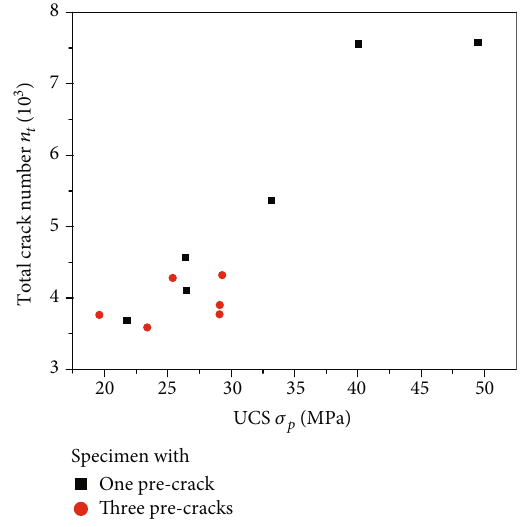
Figure 15: Correspondence between the UCS and the new crack number of the sandstone